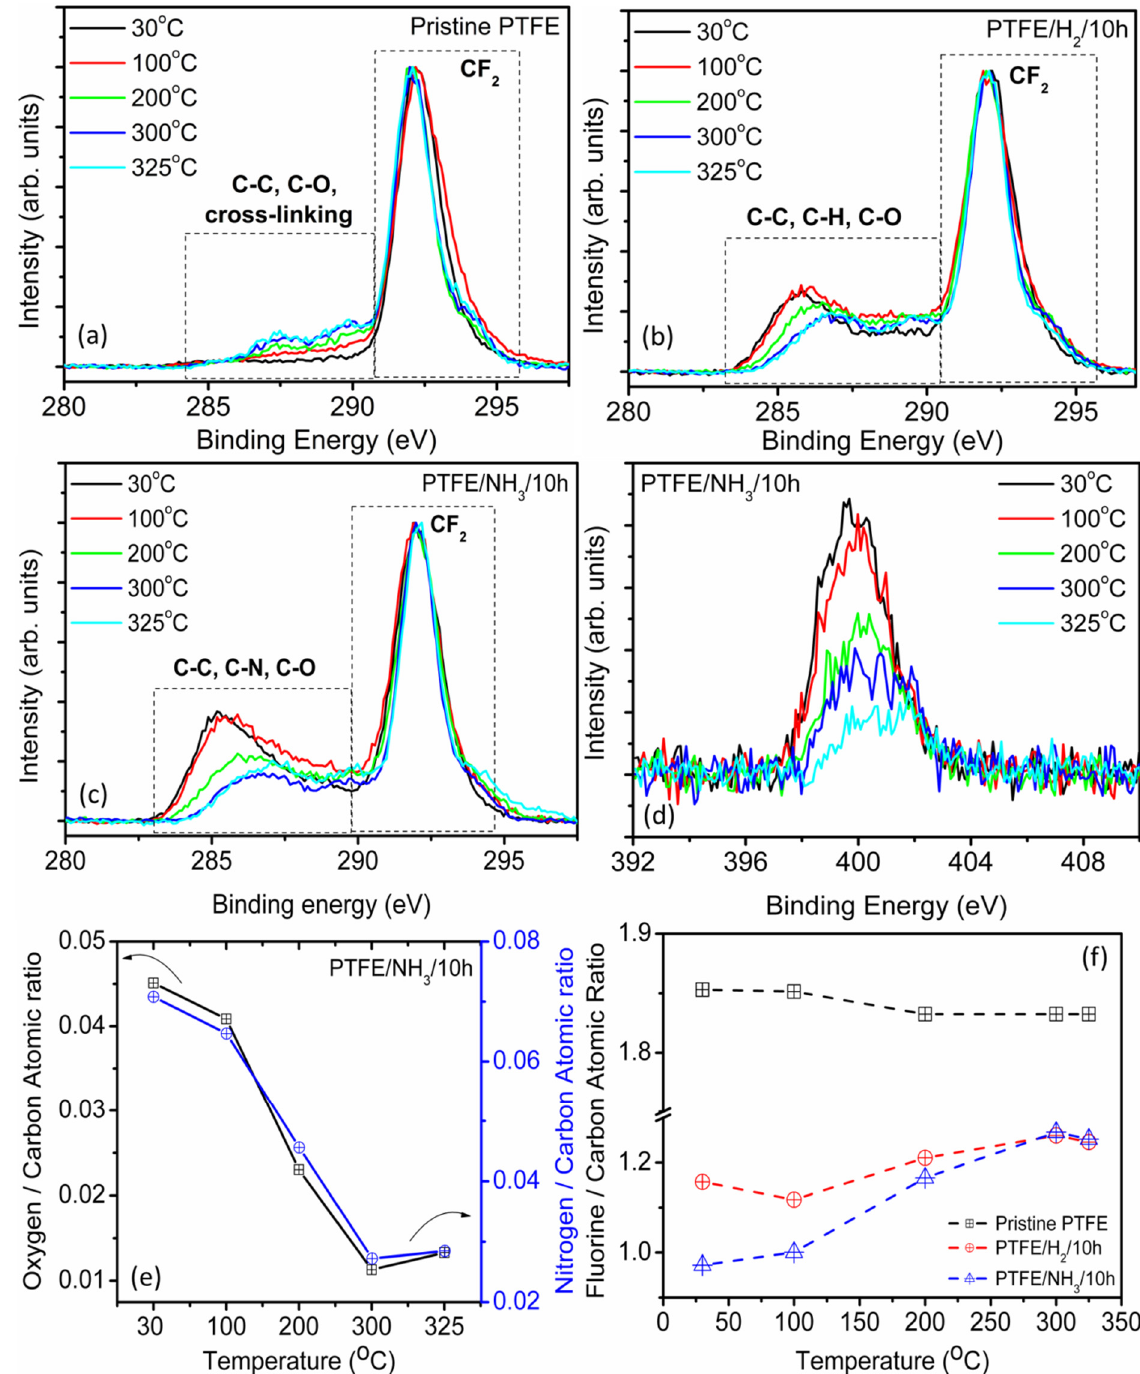
Figure 3. Temperature dependent XPS ( a ) C1s core level XPS spectra for pristine PTFE. ( b ) C1s core level XPS spectra for PTFE/H2/10 h sample. ( c ) C1s core level XPS